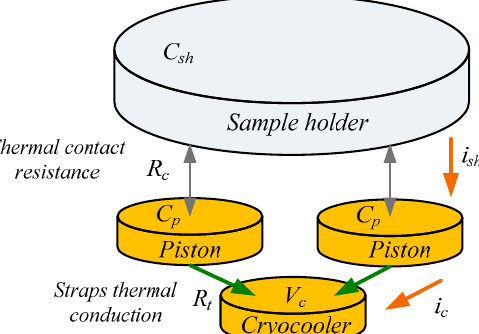
Figure 5. Simplified scheme of the thermal system for lumped network analysis.